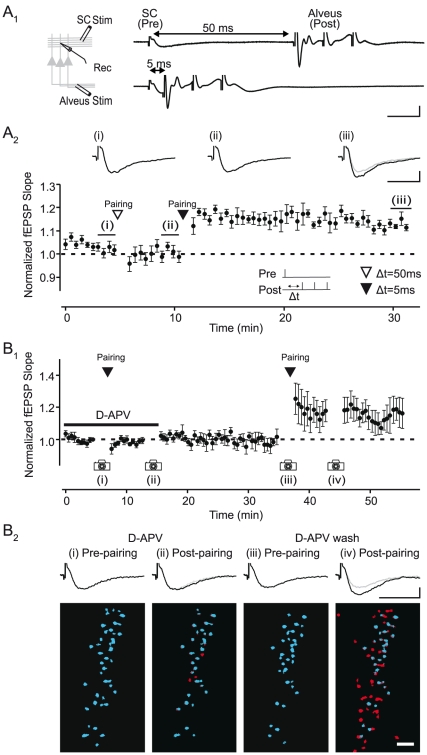
Timing-dependent associative synaptic plasticity enlarges active neural ensembles.A1 Left, recording configuration. Right, induction protocol for studying timing-dependent plasticity. Example traces show the SC-evoked field EPSP followed 50 ms (top) or 5 ms (bottom) later by alveus stimulation (3 pulses, 100 Hz). A2, Summary plot of timing-dependent LTP of SC fEPSPs induced by paired pre- and postsynaptic activity (n = 5). Single SC-evoked EPSPs (pre) were paired with brief trains of alveus stimulation (post, 3 pulses, 100 Hz) for 30 trials at 0.5 Hz. Pairing of alveus stimuli 50 ms following presynaptic activity (open triangle) had no effect on the fEPSP, while subsequent pairing using a 5 ms delay led to stable LTP. Top, representative fEPSPs recorded at the time points indicated on the summary plot. B, Pairing-induced LTP is NMDAR-dependent and enhances the number of pyramidal cells belonging to the SC ensemble. B1, Pairing SC and alveus stimulation (5 ms delay) in the presence of D-APV (50 µM) has no effect on the fEPSP, while subsequent pairing following drug washout elicits LTP (n = 5). B2, Pairing-induced LTP of fEPSPs is accompanied by an enlargement of the SC ensemble. Activity maps of SC-evoked CA1 cell ensembles from a representative experiment. Images and corresponding fEPSPs were acquired during the periods indicated by cameras in B1. Activated neurons in the pyramidal cell layer are color-coded blue and cells added after pairing are colored red. Scale bar for activity maps, 50 µm. Scale bars for fEPSPs, 0.5 mV and 20 ms.